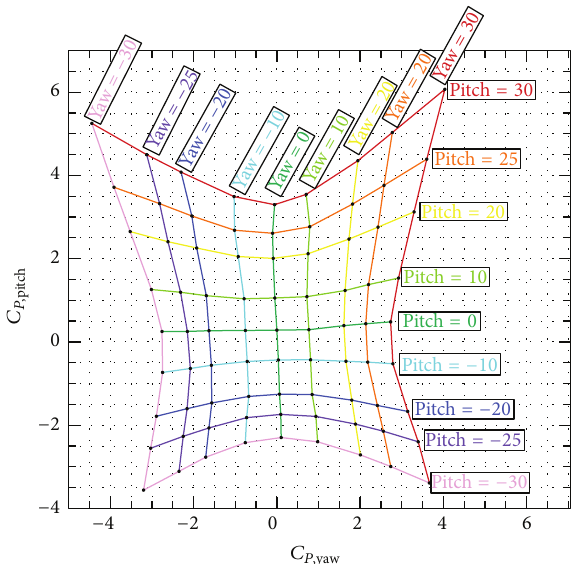
Figure 8: Coefficient of yaw and pitch with lines of constant pitch or yaw angles, 81 (9 × 9) points.